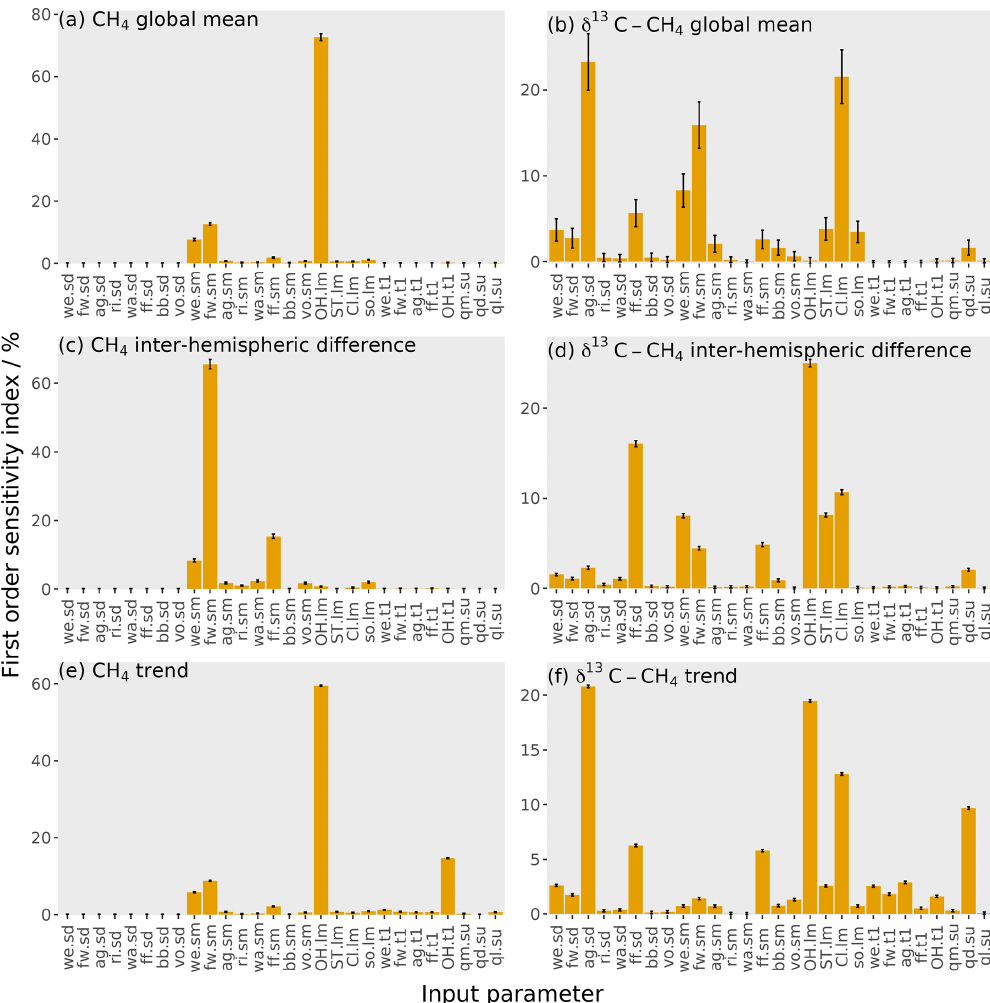
Figure 7. The orange bars show the first-order sensitivity coefficients to the input parameters, with the error bars showing the uncertainty in these indices (calculated using bootstrap resampling; see Supplement). Each panel is for one of six outputs: (a) mole fraction global mean, (b) δ 13 C–CH 4 global mean, (c) mole fraction inter-hemispheric difference, (d) δ 13 C–CH 4 inter-hemispheric difference, (e) mole fraction trend, and (f) δ 13 C–CH 4 trend. The values given here are for the temporal mean of the time series. The input parameter codes are given by a combination of a two-character code giving the source or loss (wetlands, we; fresh water, fw; agriculture, ag; rice, ri; waste, wa; fossil fuels, ff; biomass burning, bb; volcanoes, vo; hydroxyl radical, OH; stratospheric, ST; Cl radical, Cl; soil, so; total source magnitude, qm; total source δ 13 C–CH 4 signature, qd; total loss imbalance, ql) and another code giving the type of parameter (source δ 13 C–CH 4 signature, sd; source magnitude, sm; loss magnitude, lm; temporal trend, t1; spin-up,